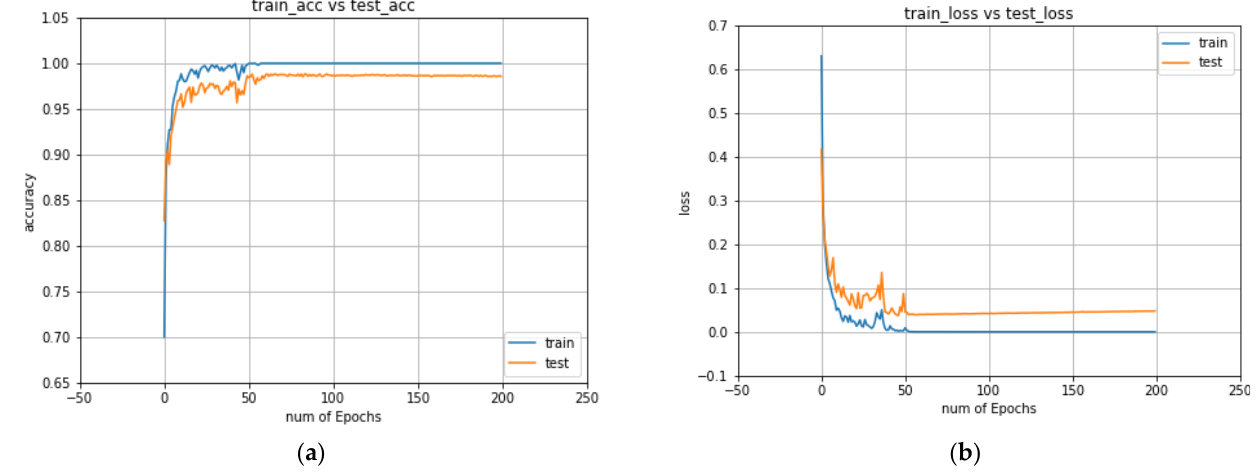
Figure 11. The accuracy ( a ) and loss curves ( b ) of the ANN model.